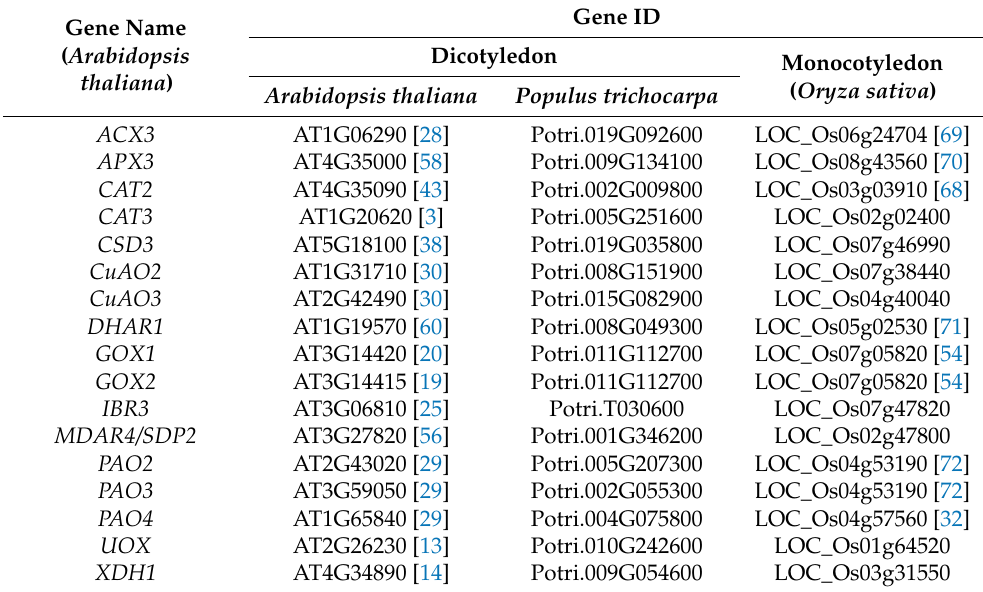
Table 1. Genes involved in Arabidopsis peroxisomal ROS metabolism and their homologous genes in poplar and rice. Gene Name ( Arabidopsis thaliana )